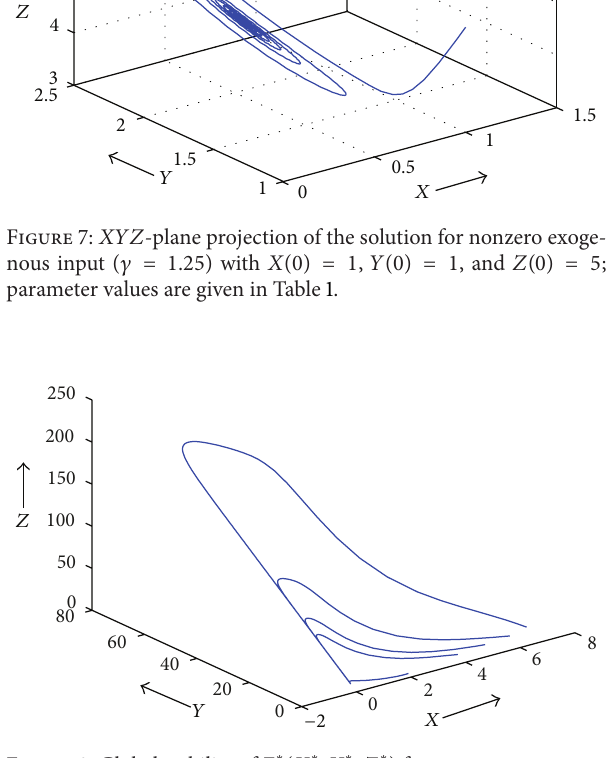
Figure 8: Global stability of 𝐸 ∗ (𝑋 ∗ , 𝑌 ∗ ,𝑍 ∗ ) for nonzero exogenous input( 𝛾 = 1.25 )with (𝑋(0), 𝑌(0),𝑍(0)) = (2,1, 3), (4,3, 5),(6, 4,8), (5,3, 8), (7,8, 4) , parameter values are given in Table